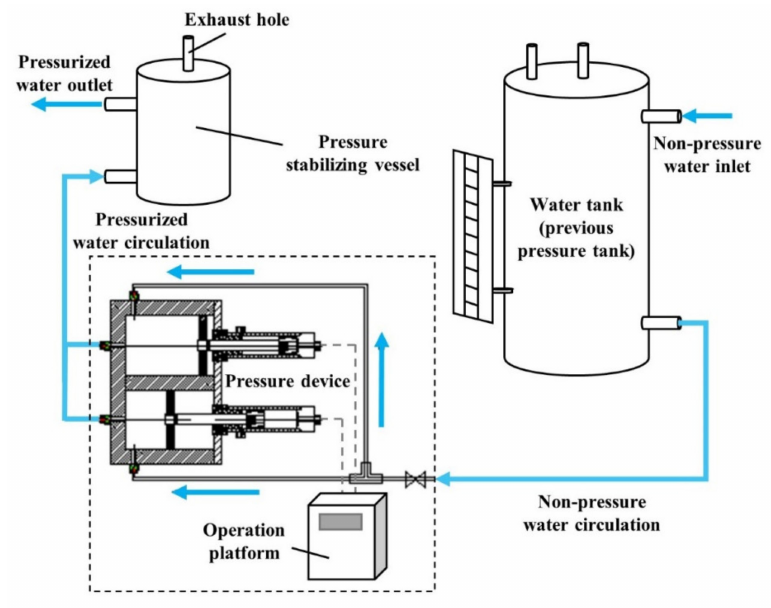
Figure 2. General disposition of the novel water provision